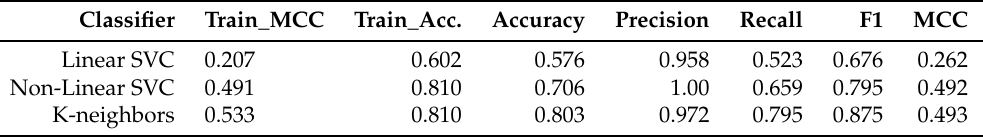
Table 3. Model’s scores (Accuracy, Precision, Recall, F1, and MCC) by type of classifier and test